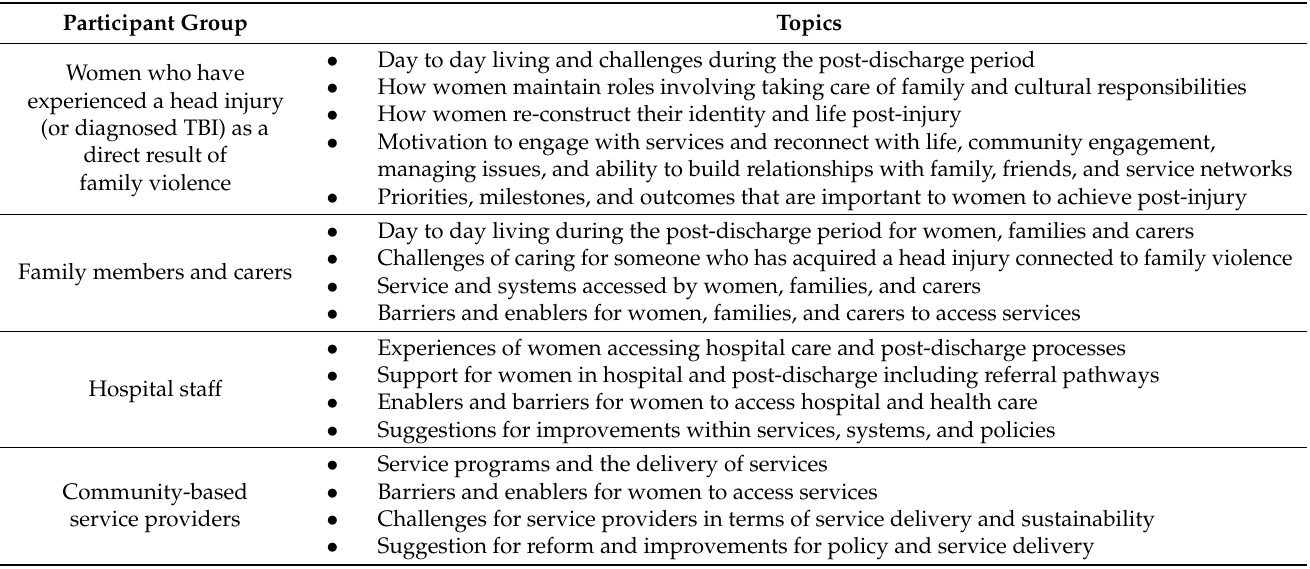
Table 2. Overview of the interview and discussion group